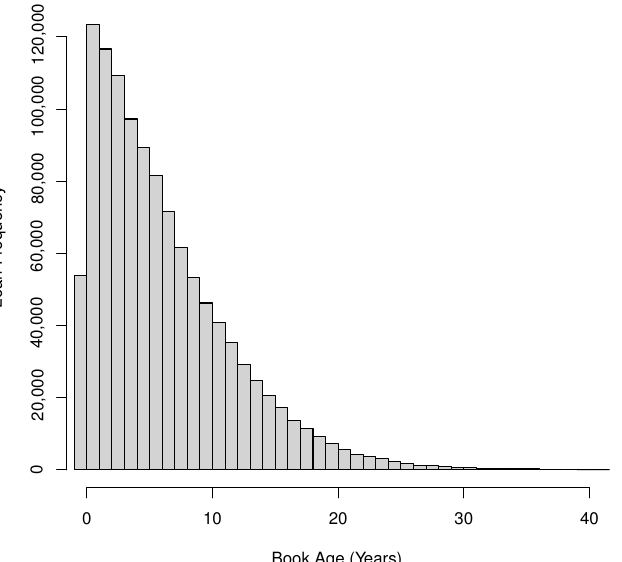
Figure 4. Loan frequency with respect to book age.